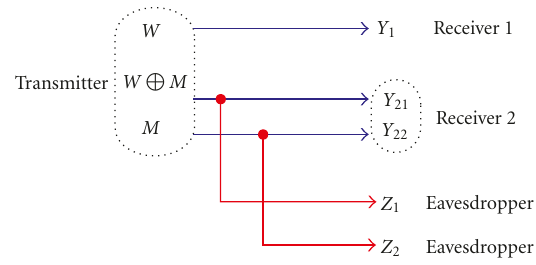
Figure 5: Illustration of Scheme